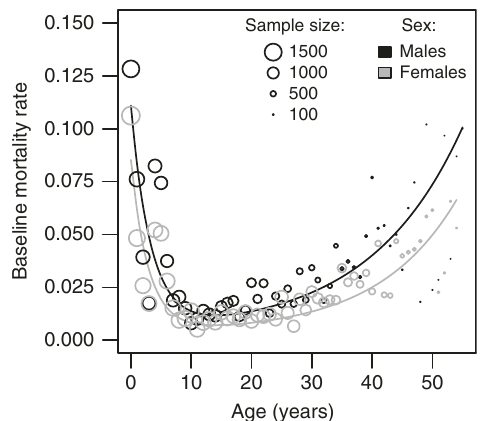
Fig. 1 Baseline yearly mortality rates of males and females in Myanmar timber elephant population. Lines depict predictions from model averaging of all model fi ts presented in Table 1. Predictions were made for an average male (black) and female (gray) that would have been born in captivity from the birth cohort 1980 at Sagaing (the time and place accounting for the highest proportion of our data). Other conditions do not impact the general bathtub shape of the mortality function. Dots represent yearly mortality rates for each sex directly computed using raw data without accounting for capture status, birth cohort or living region. The diameter of the dots is proportional to the number of yearly elephant observations (Total =